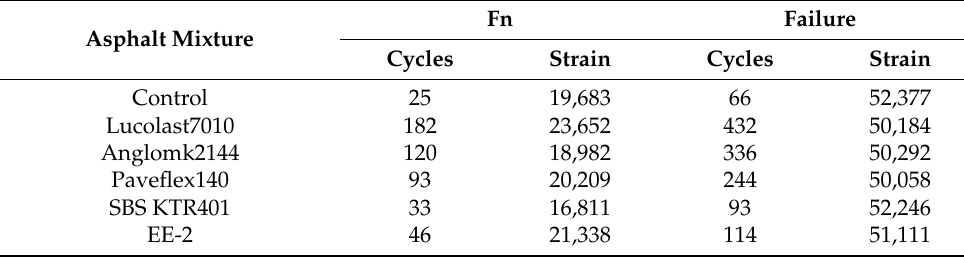
Figure 10. Cumulative permanent strain curves for different mixtures. Table 12. Flow number test data for different mixtures.